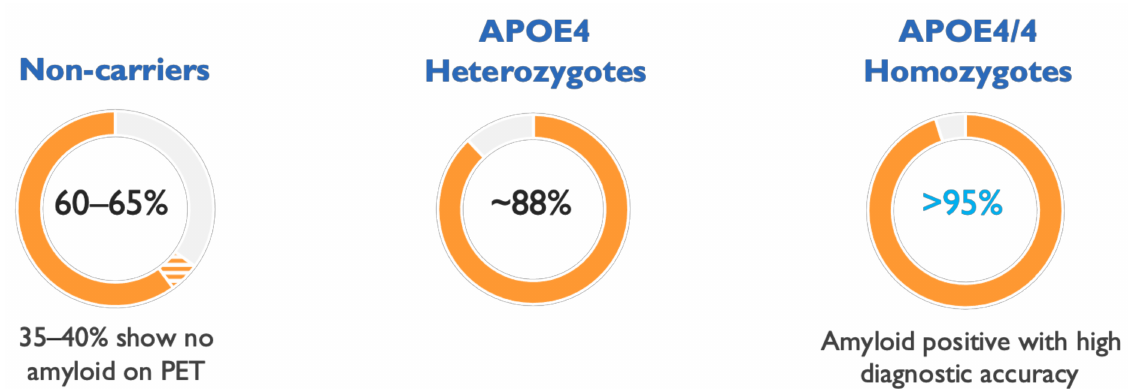
Figure 4. Clinical diagnosis of Alzheimer’s disease (AD) in patients with the APOE4/4 genotype shows high accuracy. The ε 4 allele of apolipoprotein E (APOE4) genotype can aid in diagnosis of AD and APOE4/4 subjects show particularly high accuracy of clinical diagnosis. The figure shows rates of positive amyloid positron emission tomography (PET) scans in AD patients by APOE4 genotype. Amyloid PET imaging in APOE4 non-carriers and APOE4 heterozygotes was positive in 65% and 88% of subjects, respectively, increasing to >95% positivity in APOE4/4 homozygotes, based on data from a solanezumab clinical trial in Mild to Moderate AD